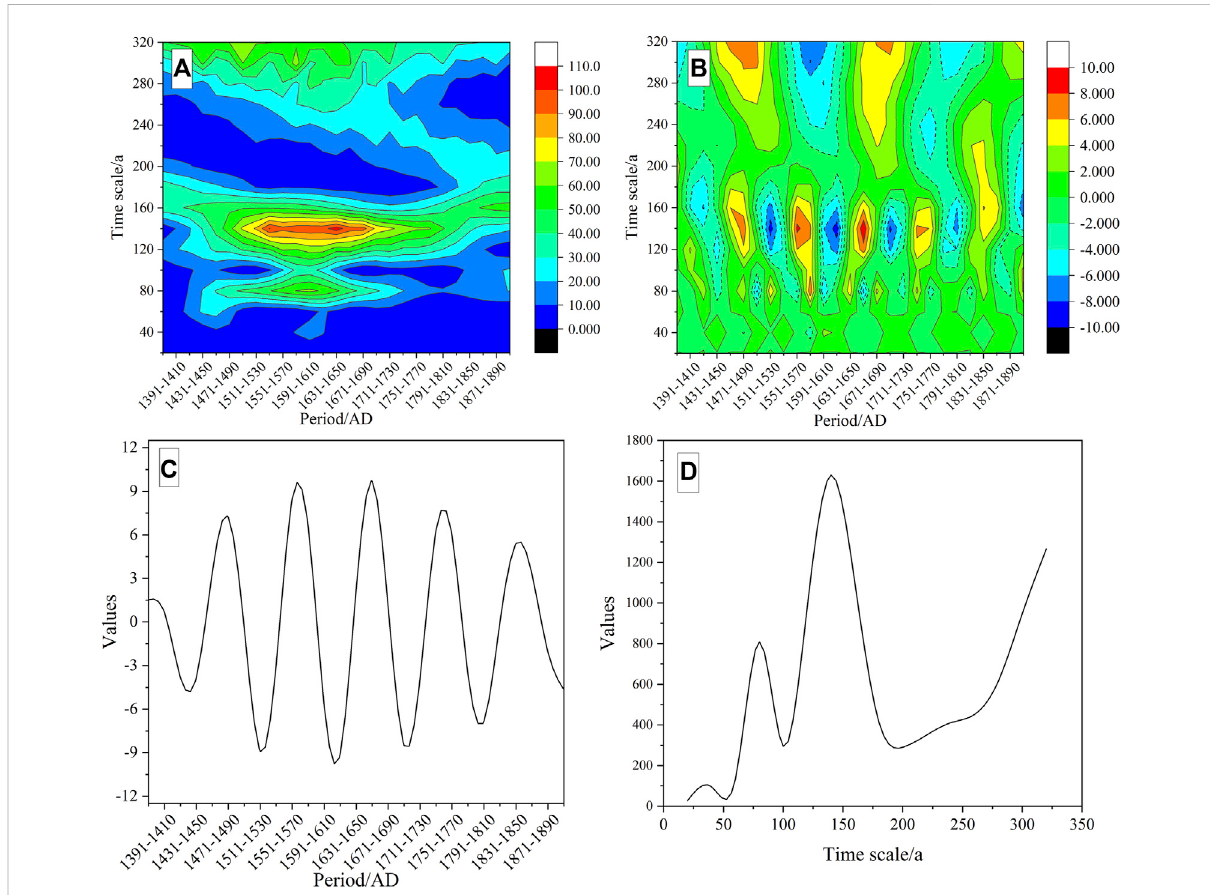
FIGURE 4 Wavelet analysis of natural disasters in Huizhou during the Ming and Qing dynasties. (A) Contour map of modulus square wavelet coef fi cient, indicatingamaincycleof140 years. (B) Realpartwaveletcoef fi cientcontourmap,indicatingaperiodicchangeof80 – 100 yearsonthetimescaleof 140 years. (C) Real values curve of wavelet coef fi cient at the time scale of 140 years, supporting the point of Figure 4B. (D) Variance curve of natural disasters at different time scales, supporting the point of Figure